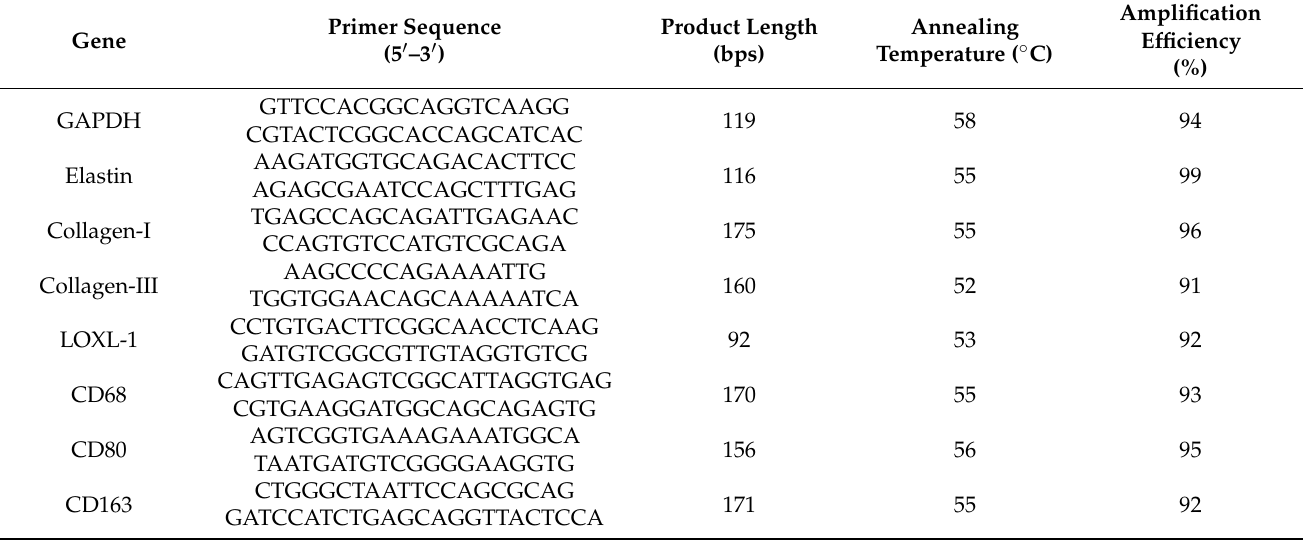
Table 2. Primers and their